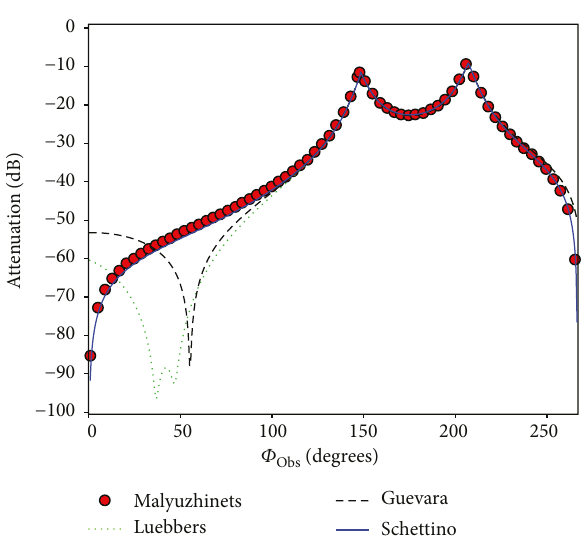
Figure 3: Attenuation of the di ff racted fi eld for TM polarization around the wedge; 0-face incidence and ϕ i = π /6 .